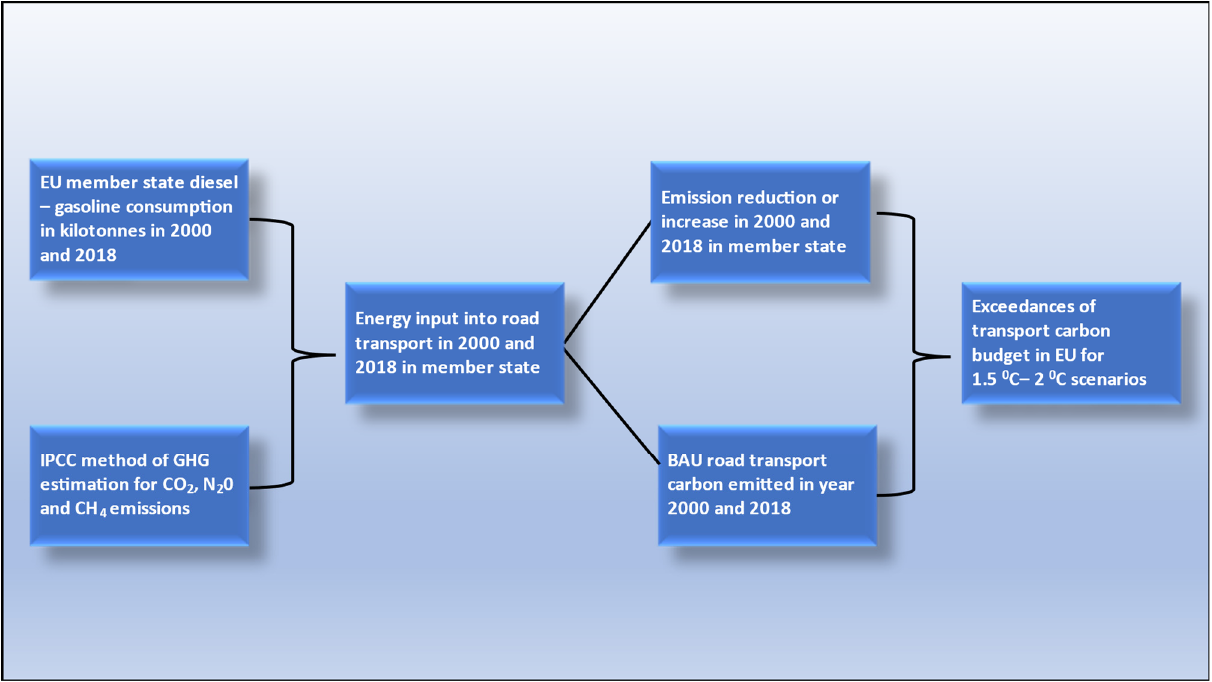
Figure 1. Flow chart of the methodology.